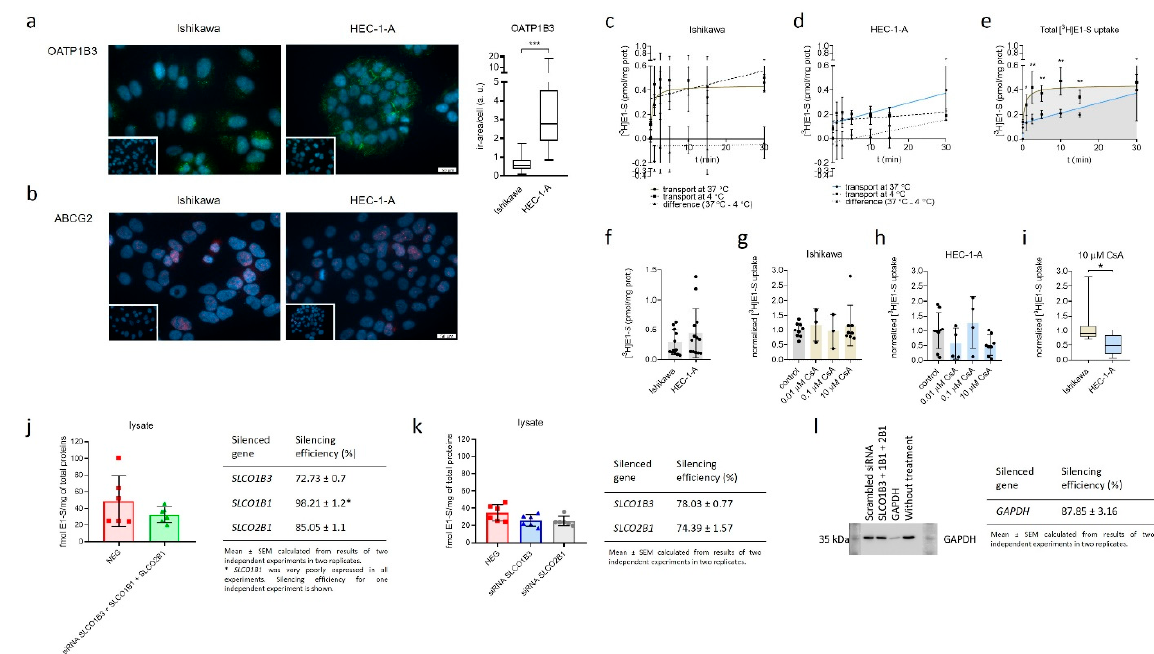
Figure 2. Immunocytochemical staining of OATP1B3 and ABCG2 and uptake of E1-S in Ishikawa and HEC-1-A. ( a ) Levels of OATP1B3 immunoreactivity in EC cell lines. Mann–Whitney U test after evaluation of 30 randomly chosen fields from three independent experiments (10 fields from each experiment). ( b ) Levels of ABCG2 immunoreactivity in EC cell lines. Representative pictures of ABCG2 staining are shown. Insets show corresponding cell lines incubated with normal rabbit ( a ) or mouse ( b ) serum. ( c , d ) Time-course of 16 nM [ 3 H]E1-S uptake at 37 °C (total transport) and 4 °C (diffusion), measured in cell lysates in three individual experiments in duplicates. Transporter-mediated uptake of E1-S was calculated by subtraction of average values at individual temperatures. ( e ) Comparison of total E1-S uptake in Ishikawa and HEC-1-A over 30-min time-course. ( f ) Absolute uptake of E1-S after 30 min (Mann–Whitney U Test). ( g , h ) Normalized uptake of 16 nM [ 3 H]E1-S after 30 min incubation with different concentrations of OATP inhibitor cyclosporine A (CsA). ( i ) E1-S uptake in the presence of 10 µ M CsA. (Mann–Whitney U test). ( j ) Uptake of [ 3 H]E1-S (2 min) after 48-h transient transfection with small-interfering RNAs targeting combination of genes SLCO1B3 , SLCO1B1 and SLCO2B1 in HEC-1-A cell line (results of two independent experiments in three replicates (Mann–Whitney U test). ( k ) Effect of silencing of individual genes, SLCO1B3 or SLCO1B1 on 2 min [ 3 H]E1-S uptake evaluated after 72-h siRNA transfection (two independent experiment in three replicates, Kruskal–Wallis with Dunn’s Multiple comparisons). ( l ) Western blot experiment confirming silencing of a control GAPDH (silencing efficiency (%) mean ± SEM, 87.85 ± 3.16) in two independent experiments in three replicates. In all experiments, silencing efficiency was calculated based on the expression of evaluated genes in NEG, cells treated with scrambled siRNA. Results of E1-S uptake were normalized to the total amount of proteins in cell lysates in individual treatments. Data are shown as mean ± SD. ir-area—immunoreactive area; a. u.—arbitrary unit, ns— p -value > 0.05, * p